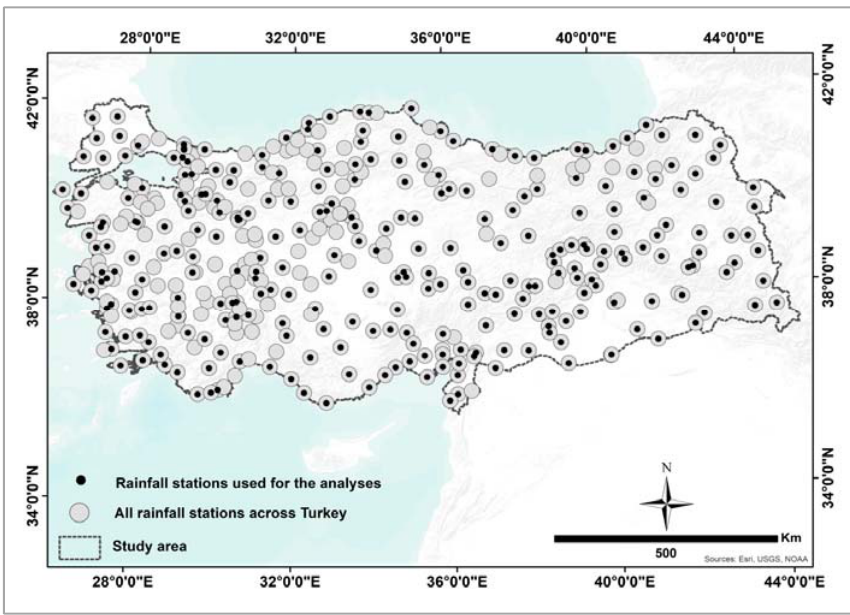
Figure 4. Spatial distribution of rainfall stations in Turkey.